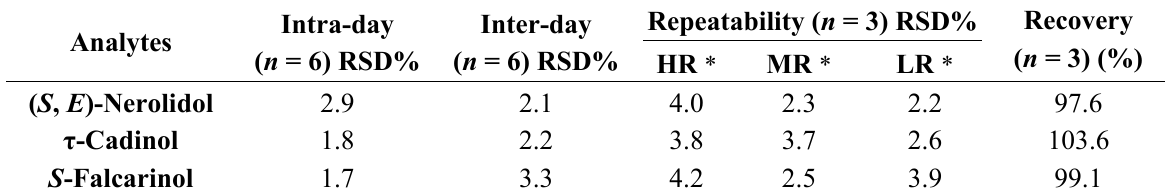
Table 1. Precision and recovery of investigated volatiles in roots bark of O. horridus